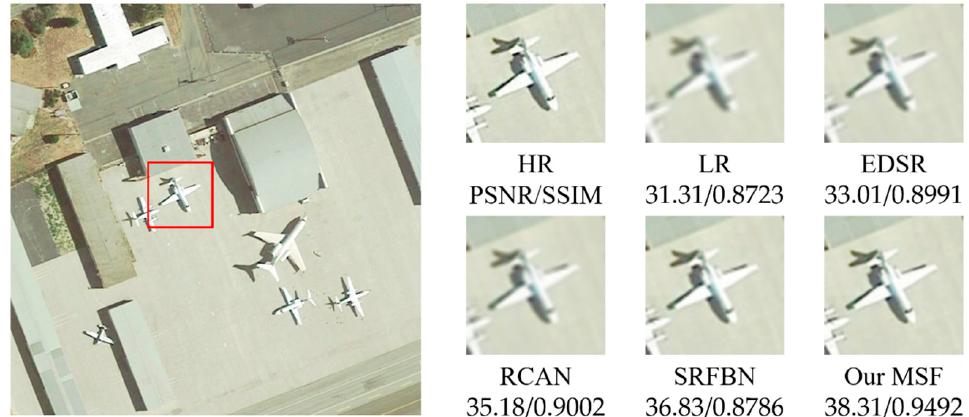
Figure 5. Qualitative comparison between different SR models performance on vehicle instance-class.